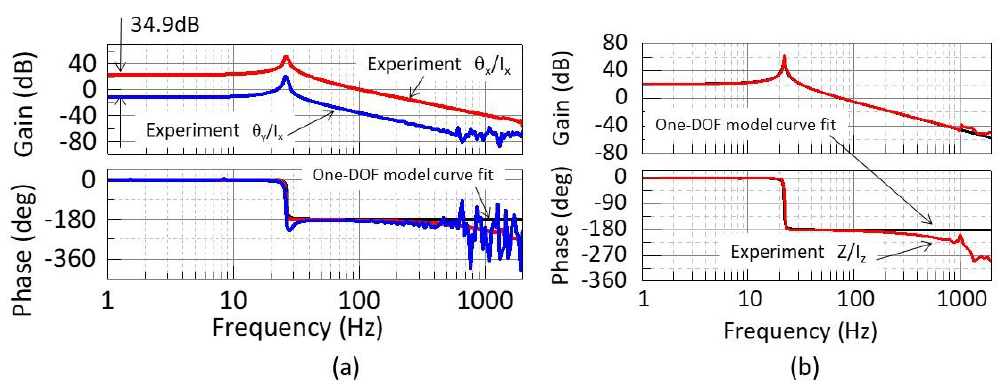
Figure 10. Frequency responses of the FSM using the magnetic suspension: ( a ) Bode plot from the VCM input current ( I x ) for θ x and θ y ; ( b ) Bode plot from the VCM input current ( I z ) for z .